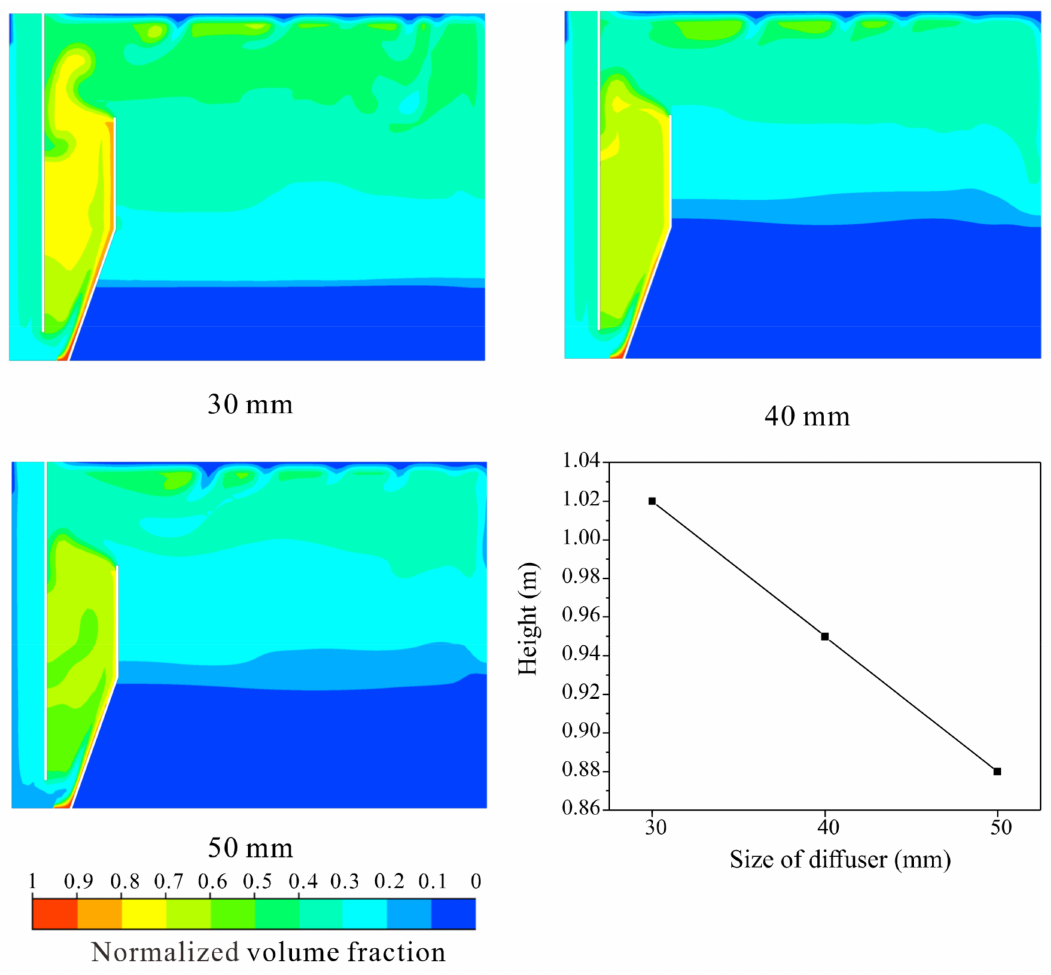
Figure 8. Effect of the size of microporous diffuser on air